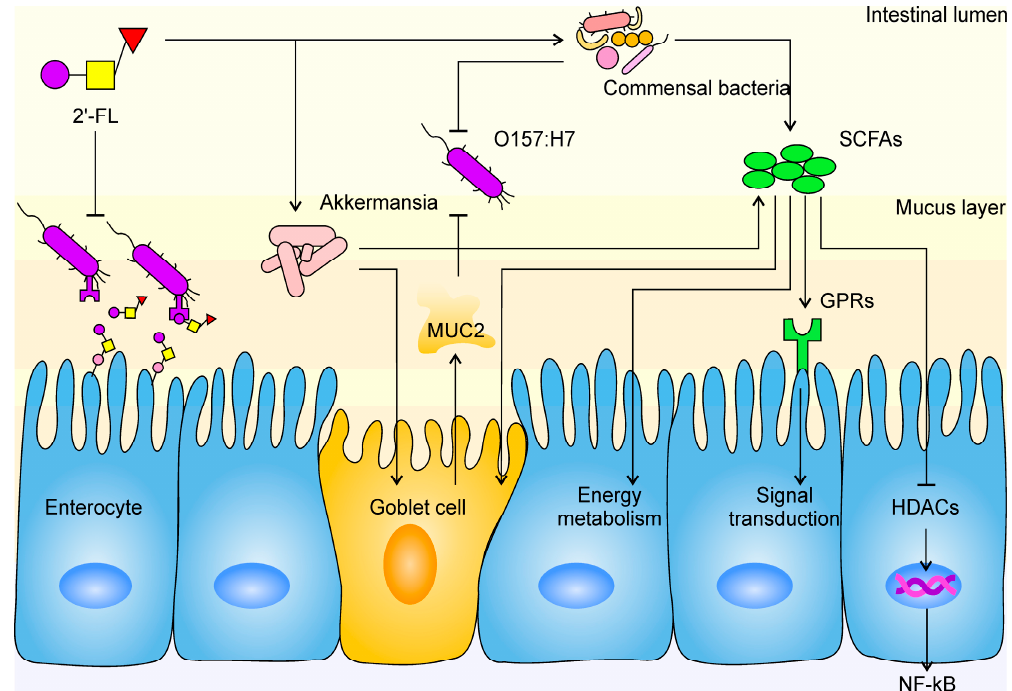
Figure 7. The mechanism of 2’-FL protection against E. coli O157 infection in the intestine. The tapered arrow indicates a promoting effect, while the flat end indicates an inhibiting effect. Mucoprotein-2, MUC2 ; short-chain fatty acids, SCFAs; histone deacetylases, HDACs; G protein-coupled receptors, GPRs; nuclear factor kappa-B, NF- κ B.